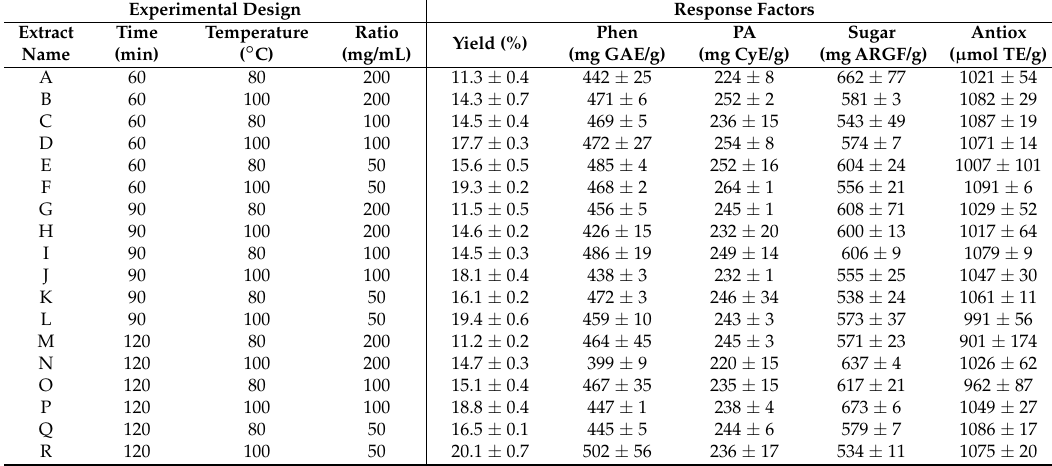
Table 1. Factorial design for the optimization of black spruce bark